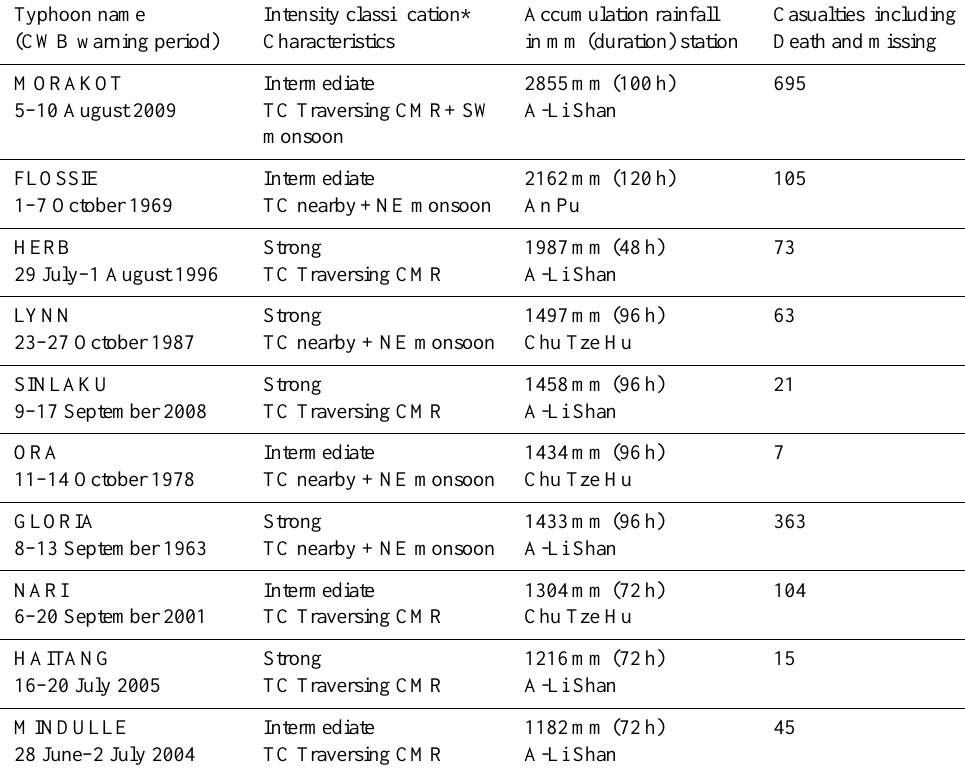
Table 1. Record of the 10 highest typhoon rainfall accumulations during the last 50 years. Stations’ elevation for A-Li station, An Pu and Chu Tze Hu are 2413m, 826m and 607m, respectively (TC: Tropical Cyclone, NE: Northeasterly, SW: southwesterly).